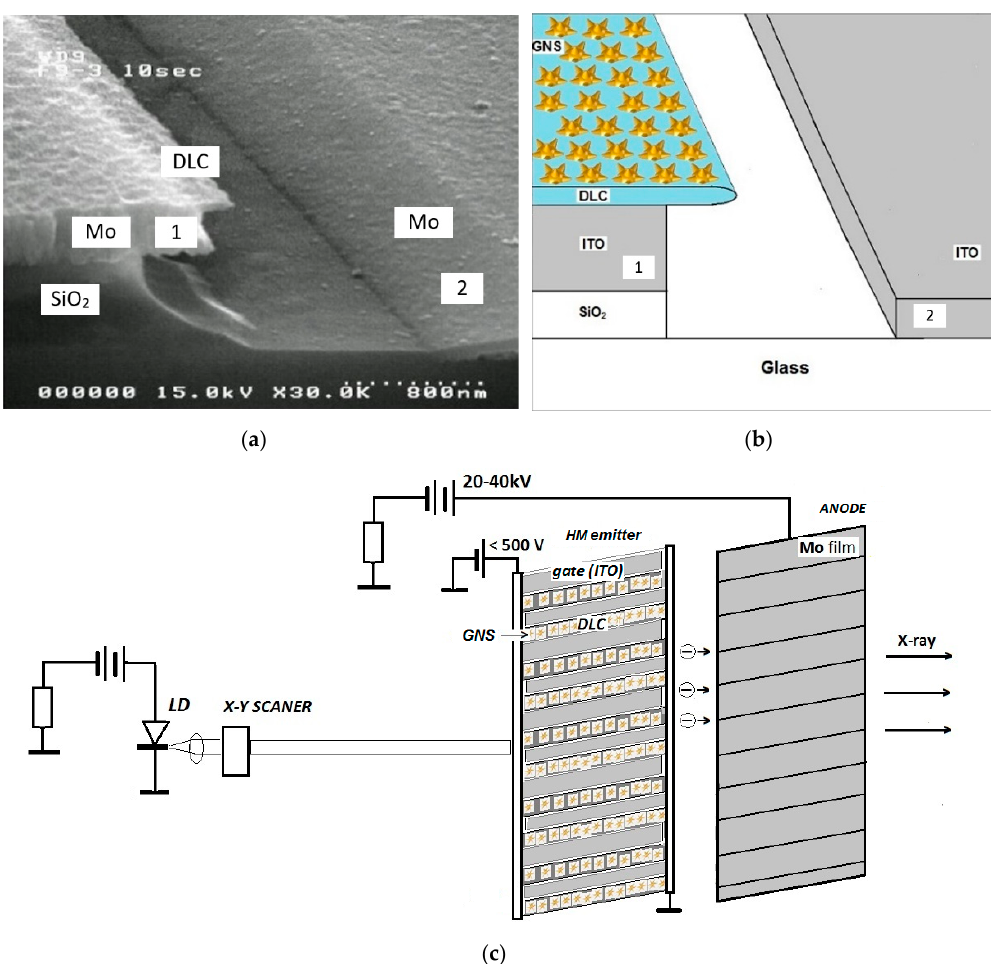
Figure 2. SEM image of a previously developed emitter in the form of a Mo–DLC blade [18] ( a ); schematic representation of the proposed hybrid nanostructured cathode cell based on hybrid material (HM) ( b ); 1–emitter; 2–gate. Block diagram of an optically controlled X–ray emitter array ( c ).